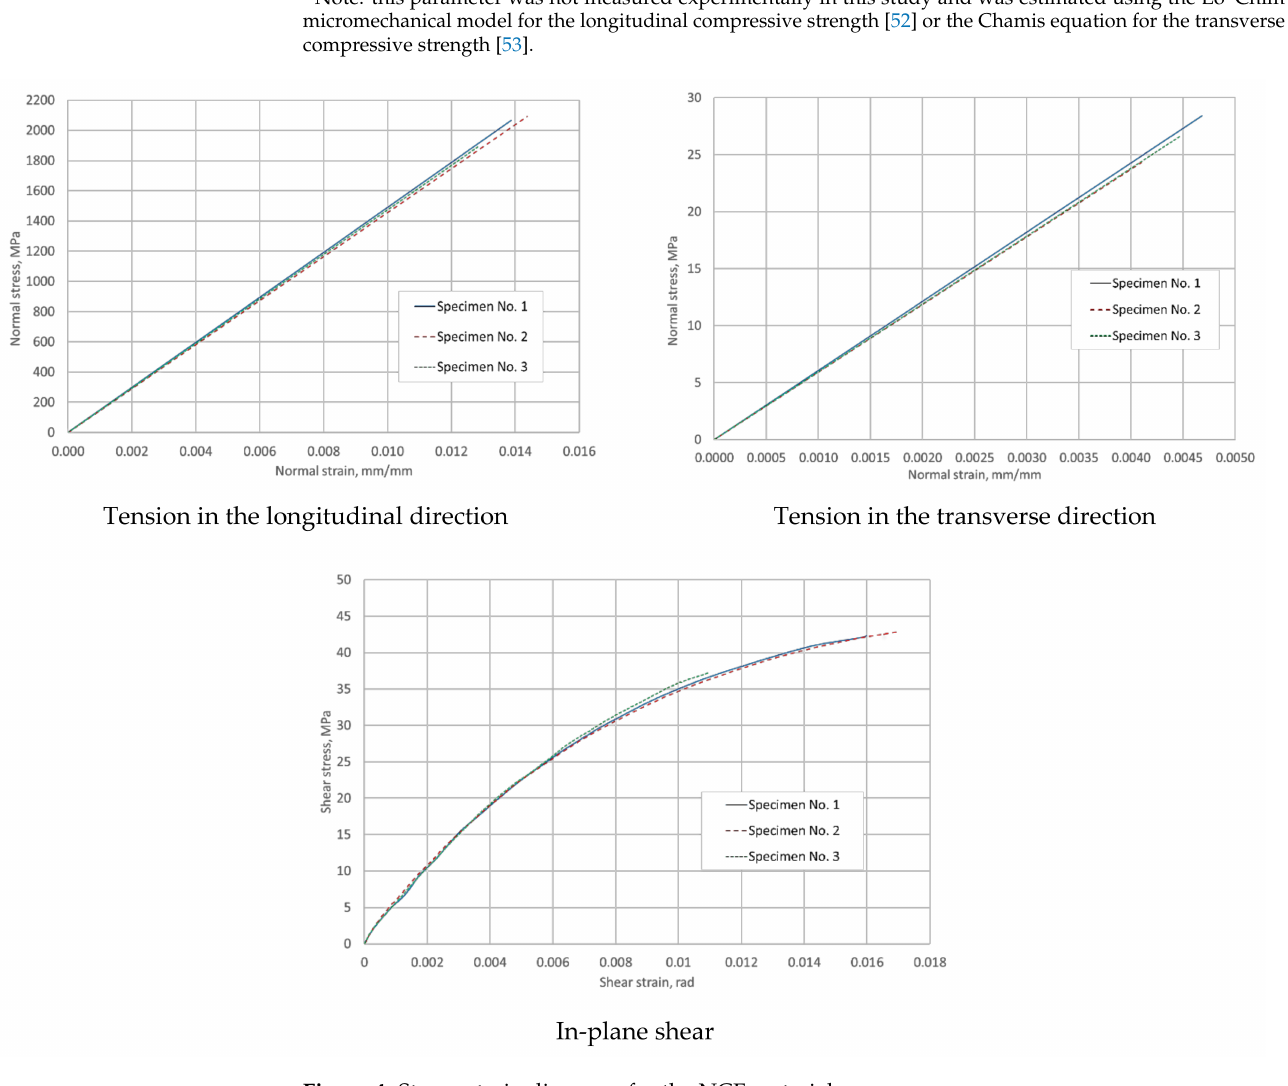
Figure 4. Stress–strain diagrams for the NCF